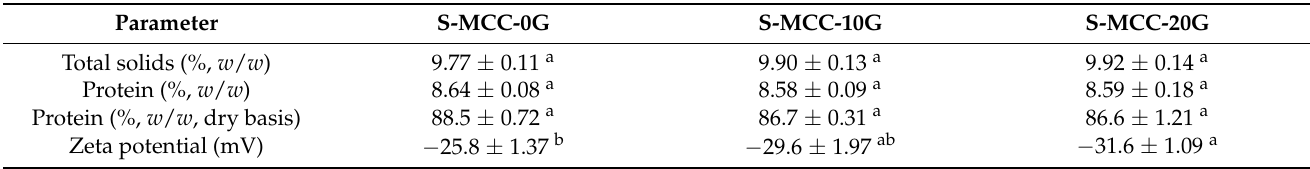
Table 1. Composition and physicochemical properties of MCC solutions mixed with 0 (S-MCC-0G), 10 (S-MCC-10G), and 20 (S-MCC-20G) % GMP as a percentage of total protein.